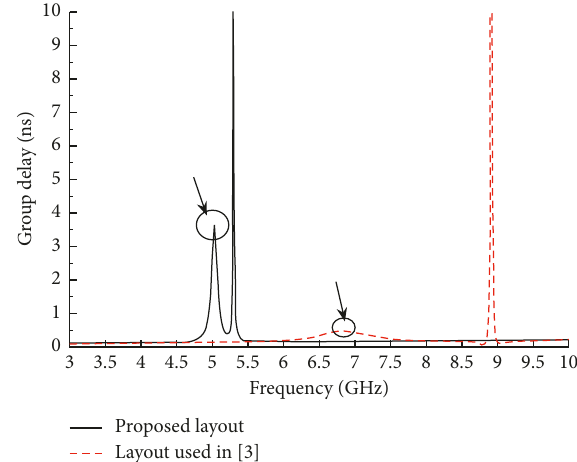
Figure 5: Simulated transmission group delay corresponding to the unit cells shown in Figures 2(a) and 2(b) [9].